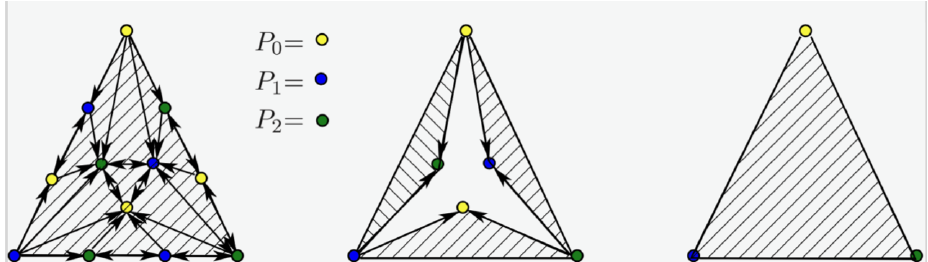
Figure 4. All possible execution (filled 2-simplexes) for three